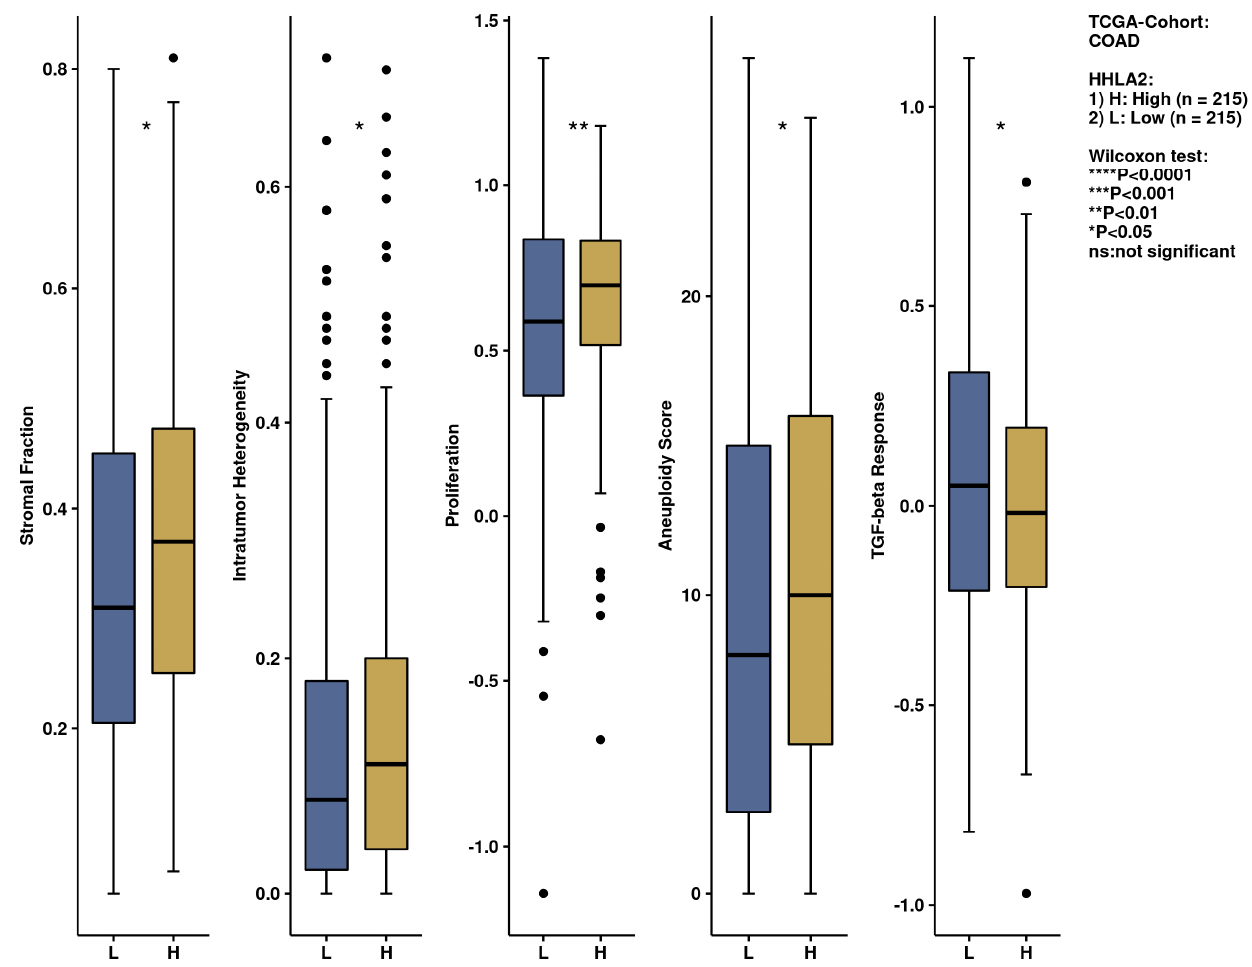
Figure 12. The immunological landscape of CRC related to HHLA2 expression, with analyses based on THE CANCER GENOME ATLAS-COLON ADENOCARCINOMA (TCGA-COAD) dataset. Immune-related scores in high- and low-HHLA2-expression groups, calculated by CIBERSORT method by the web-based tool, Camoip in high and low HHLA2 expression groups; * p < 0.05, ** p < 0.01, and *** p < 0.001; ns = not significant.